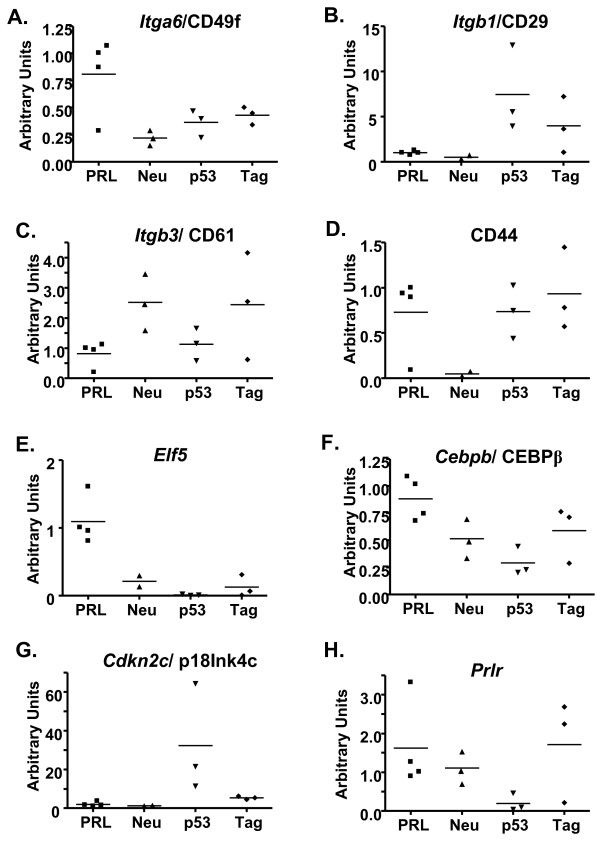
NRL-PRL adenocarcinomas express markers distinct from other well-characterized models of breast cancer. RNA from the set of mammary carcinomas in Figure 4 that developed in NRL-PRL, MMTV-neu [28], C3(1)-SV40 Tag [29], and transplanted p53-/- (O'Leary and Schuler, manuscript in preparation) models was examined for levels of transcripts implicated in mammary lineages by qRT-PCR as described in the Materials and Methods. Each symbol denotes a distinct tumor. The horizontal bar indicates the mean level for each model.